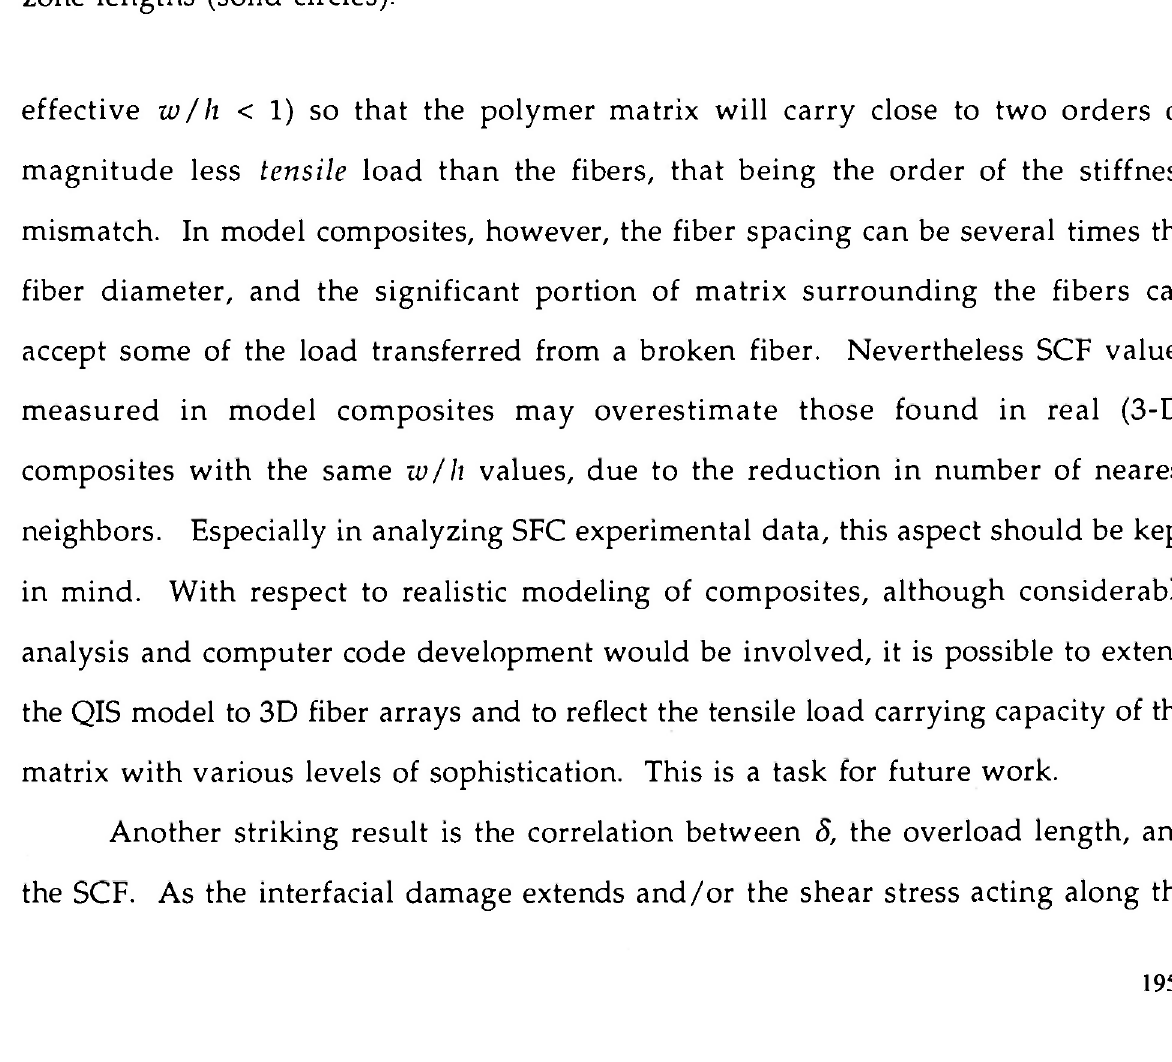
Fig. 12: QIS predicted SCF versus the estimated debond (open circles) and yield zone lengths (solid